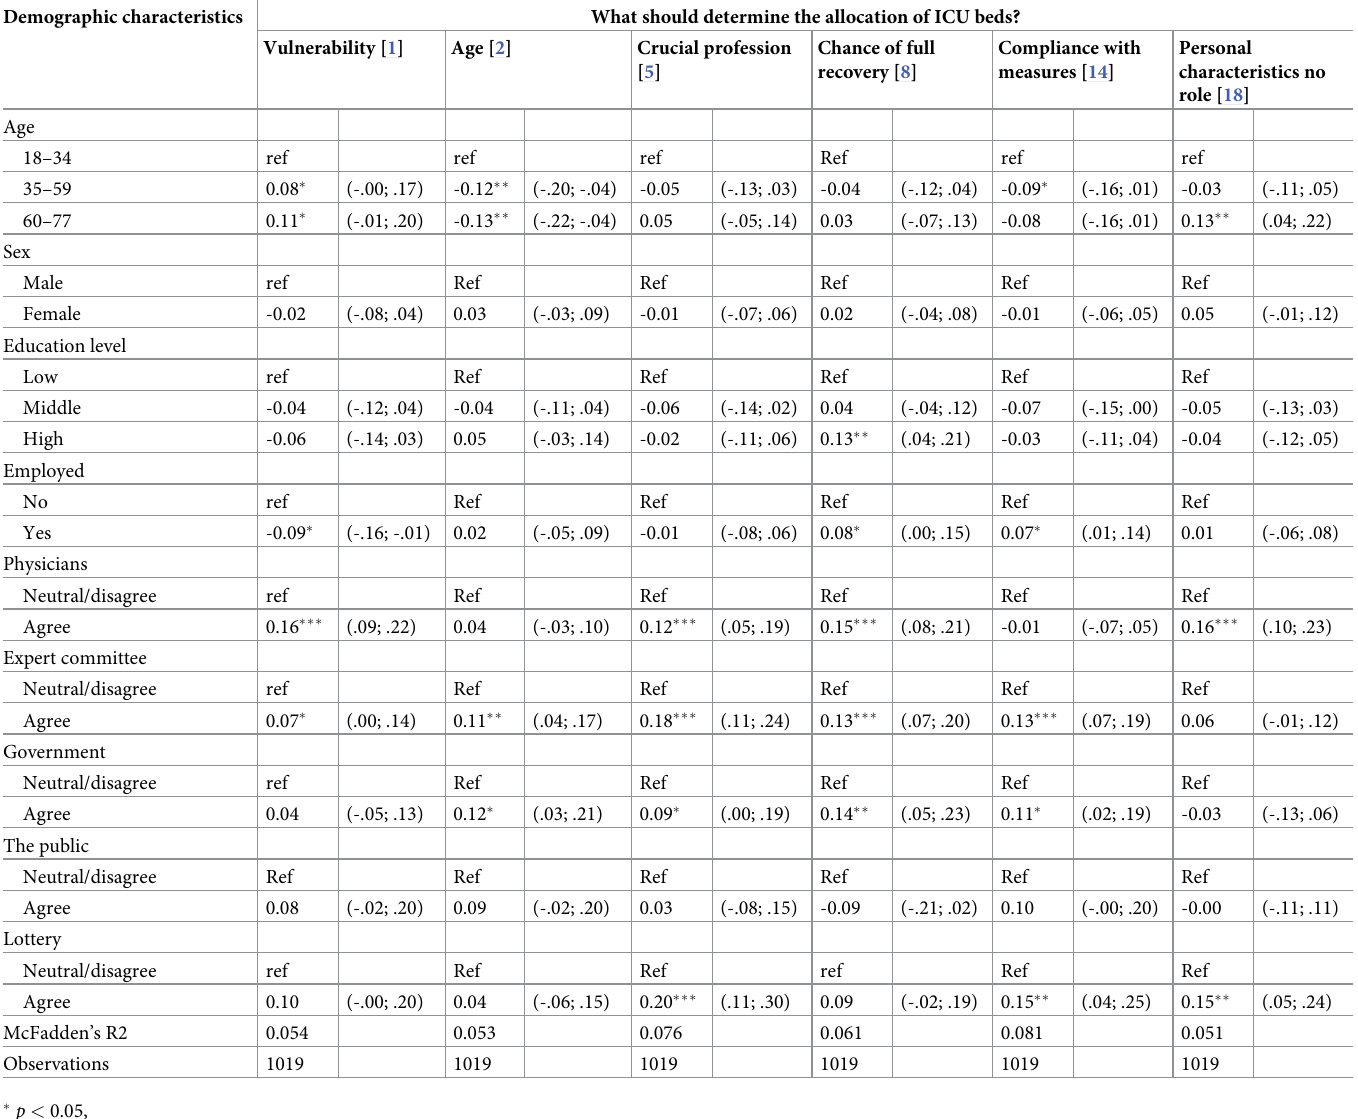
Table 5. Probit regressions decision-making criteria; average marginal effect (95% confidence